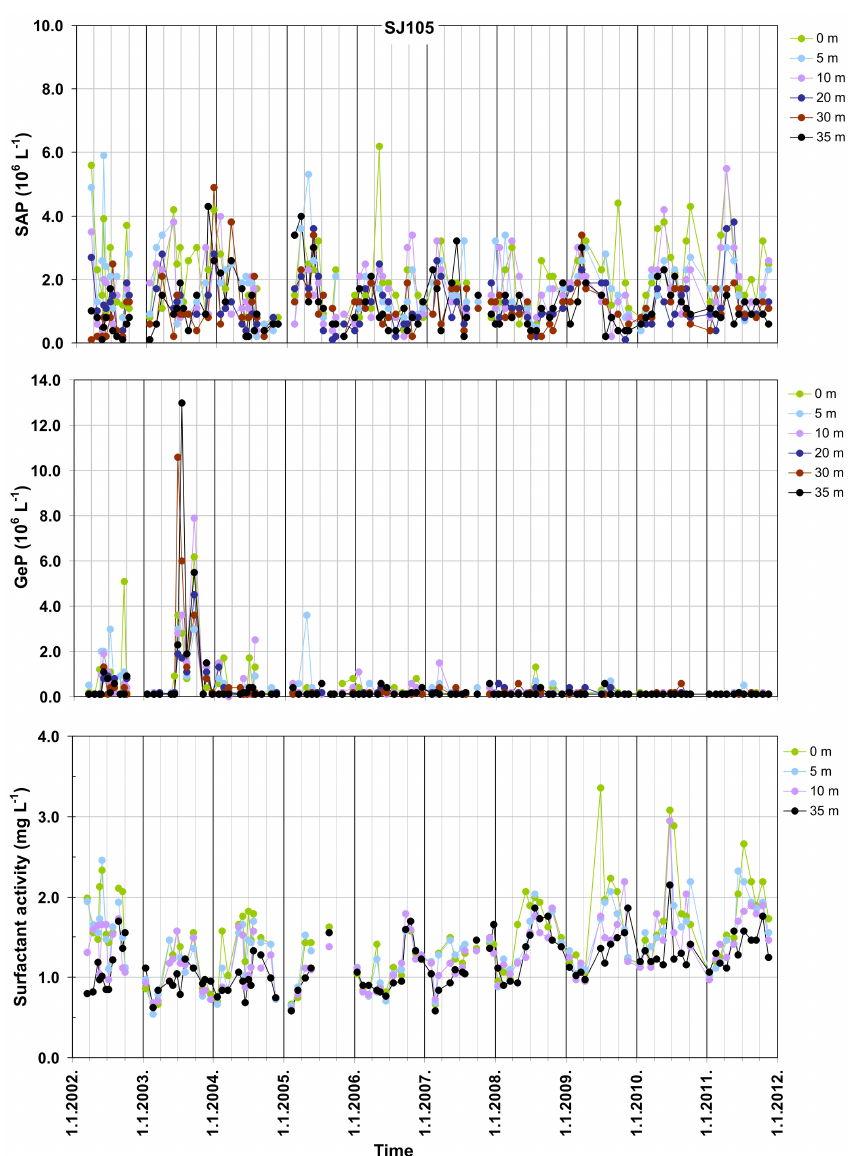
Figure 5. Annual variation of concentrations of surface-active particles (SAP), gel microparticles (GeP) and surfactant activity determined by electrochemical analysis of natural seawater samples taken at sampling station SJ 105 in the northern